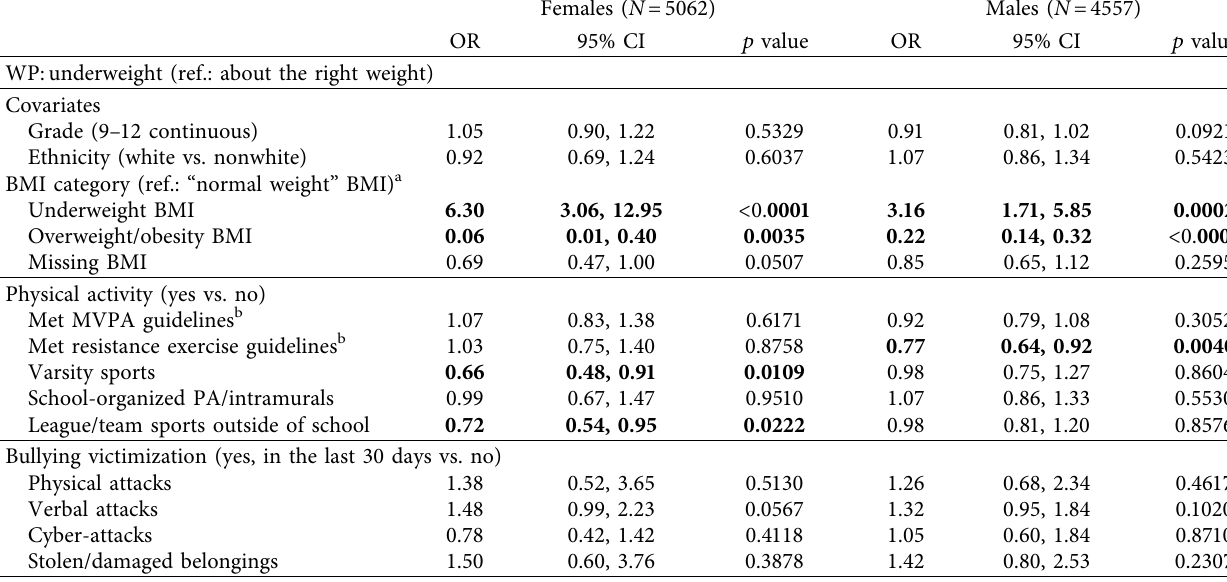
Table 3: GEE model results for predictors of youth perceiving their weight as “underweight” in Year 4 (2015/2016) of the COMPASS study among grade 9–12 students with Year 3 (2014/2015) WPs of “about the right weight.”